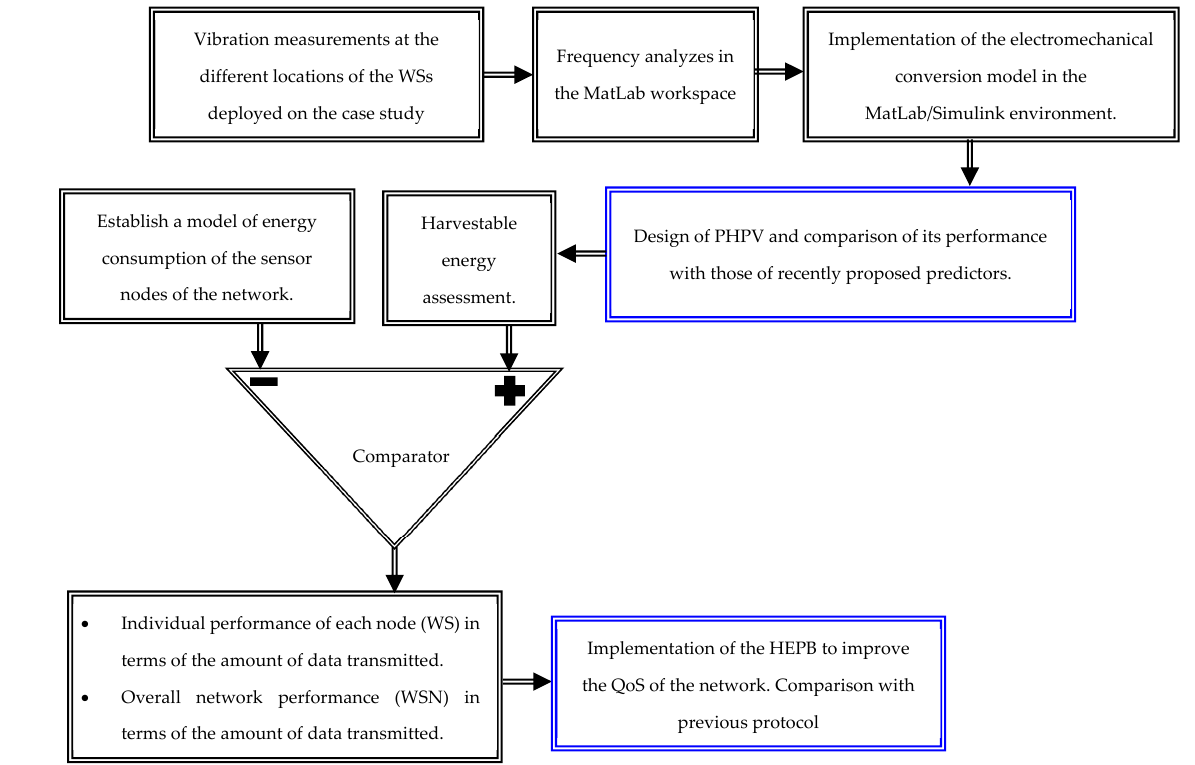
Figure 1. Different steps for the implementation of the PHPV and the HEPB.